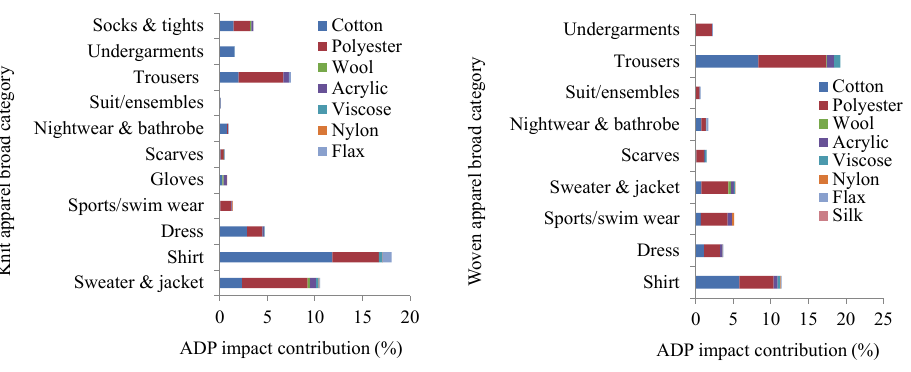
Fig. 14. ADP impact contribution of apparel broad categories based on total market share.